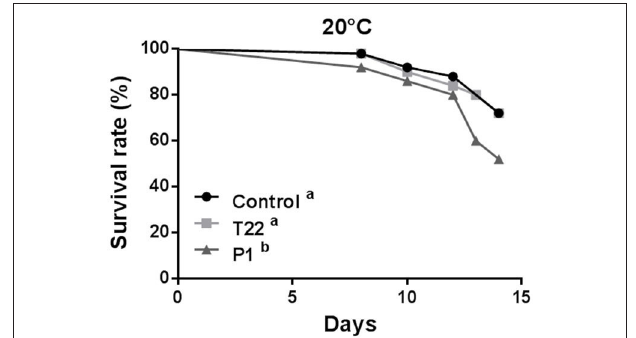
FIGURE 8 | Aphid fertility on tomato plants grown at 25 ◦ C. Offspring of Macrosiphum euphorbiae reared for their whole lifespan on T22-, P1-, and Control-tomato plants. Data represent mean ± SE. Different letters indicate a significant difference (one-way ANOVA test, P < 0.05).